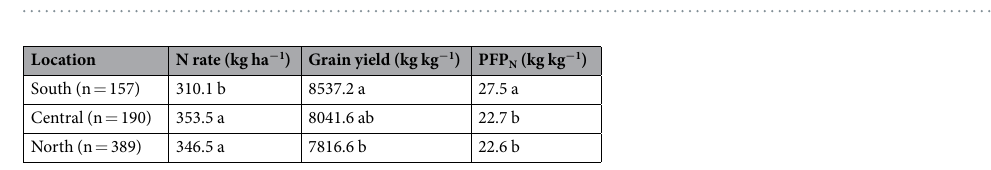
Table 1. Physical and chemical properties of the basal soil (0–20 cm, n = 1050–1350) in south, central and north Jiangsu.